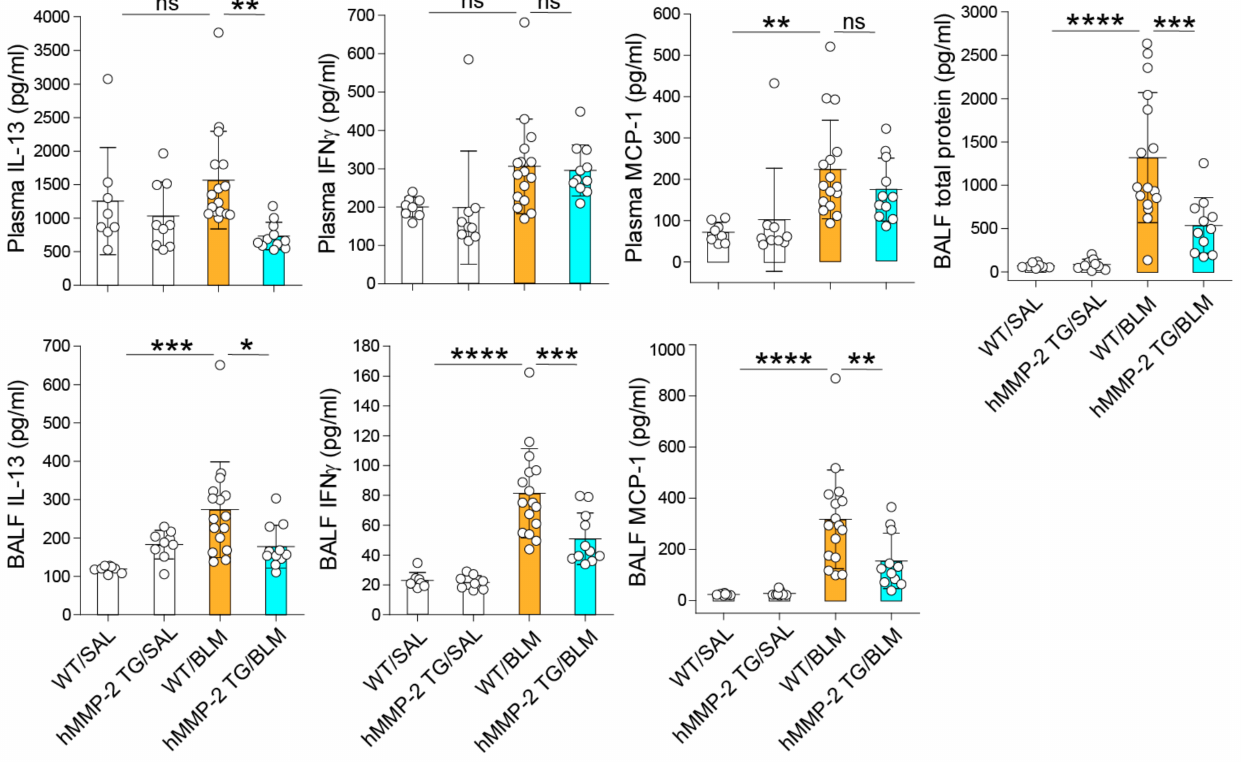
Figure 2. Reduced inflammatory cytokines and total protein in hMMP-2 TG mice. Inflammatory cytokines and chemokines were measured by commercially available enzyme immunoassay kits following the manufacturer’s instructions. The number of mice: n = 8 in WT/SAL, n = 9 in hMMP-2 TG/SAL, n = 16 in WT/BLM, and n = 11 in hMMP-2 TG/BLM. Data are the mean ± S.D. Statistical analysis by ANOVA with Newman-Keuls test. * p < 0.05; ** p < 0.01; *** p < 0.001; **** p < 0.0001; WT, wild-type; hMMP-2, human matrix metalloproteinase-2; SAL, saline; BLM, bleomycin; ns, not